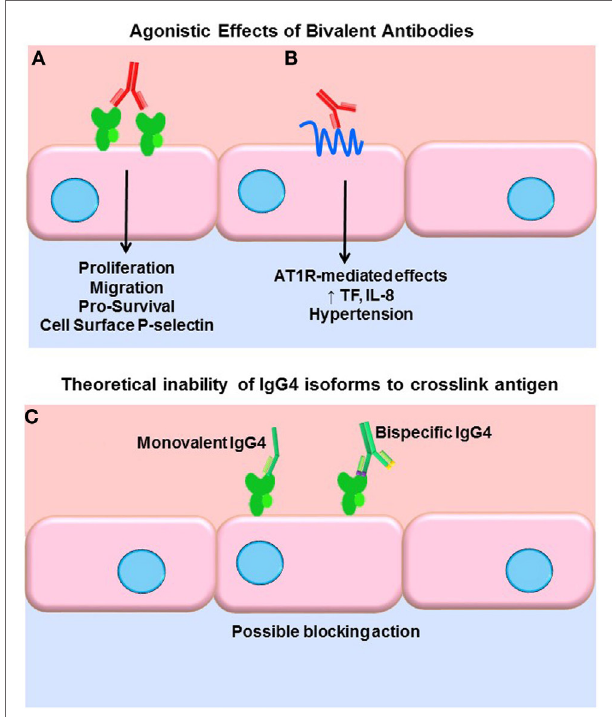
FiGURe 1 | Agonistic signaling by antibodies . (A) Bivalent IgG of any subclass may dimerize or crosslink target antigens, such as HLA molecules. Many studies have demonstrated that HLA ligation on endothelial cells, vascular smooth muscle cells, and antigen-presenting cells induces intracellular signaling via tyrosine kinases. HLA signaling promotes cell proliferation, migration, and increased expression of survival proteins such as Bcl-2 and Bcl-XL. In addition, HLA cross-linking triggers exocytosis of endothelial vesicles called Weibel–Palade bodies, which contain vasoactive mediators and the adhesion molecule P-selectin. Increased cell surface P-selectin in turn supports increased adherence of leukocytes. (B) Anti-AT1R antibodies act agonistically, binding to an epitope on this multi-pass transmembrane receptor and stimulating increased IL-8 expression and tissue factor production. AT1R agonism is also implicated in malignant hypertension in a variety of diseases as well as transplantation. (C) Some molecules of human IgG4 have been shown to form monovalent Fab arms that may cross-dimerize with other clones of IgG4 to create bispecific antibodies. Although not experimentally demonstrated, in theory, such monovalent and bispecific IgG4 molecules would be incapable of cross- linking HLA and might in fact block other subclasses from